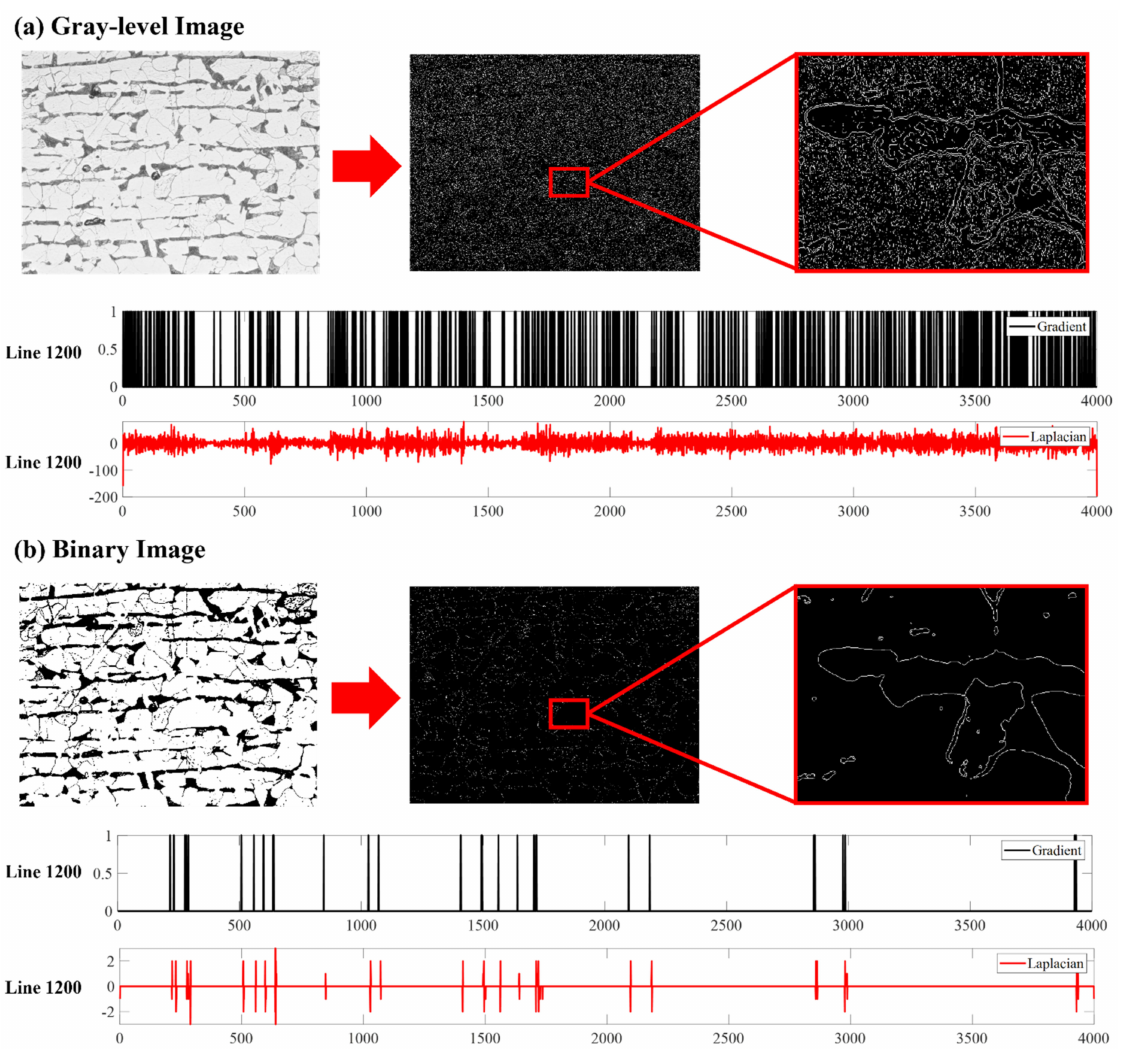
Figure 1. Comparison of edge detection algorithm using gradient and Laplacian filter: ( a ) gray-level and ( b ) binary